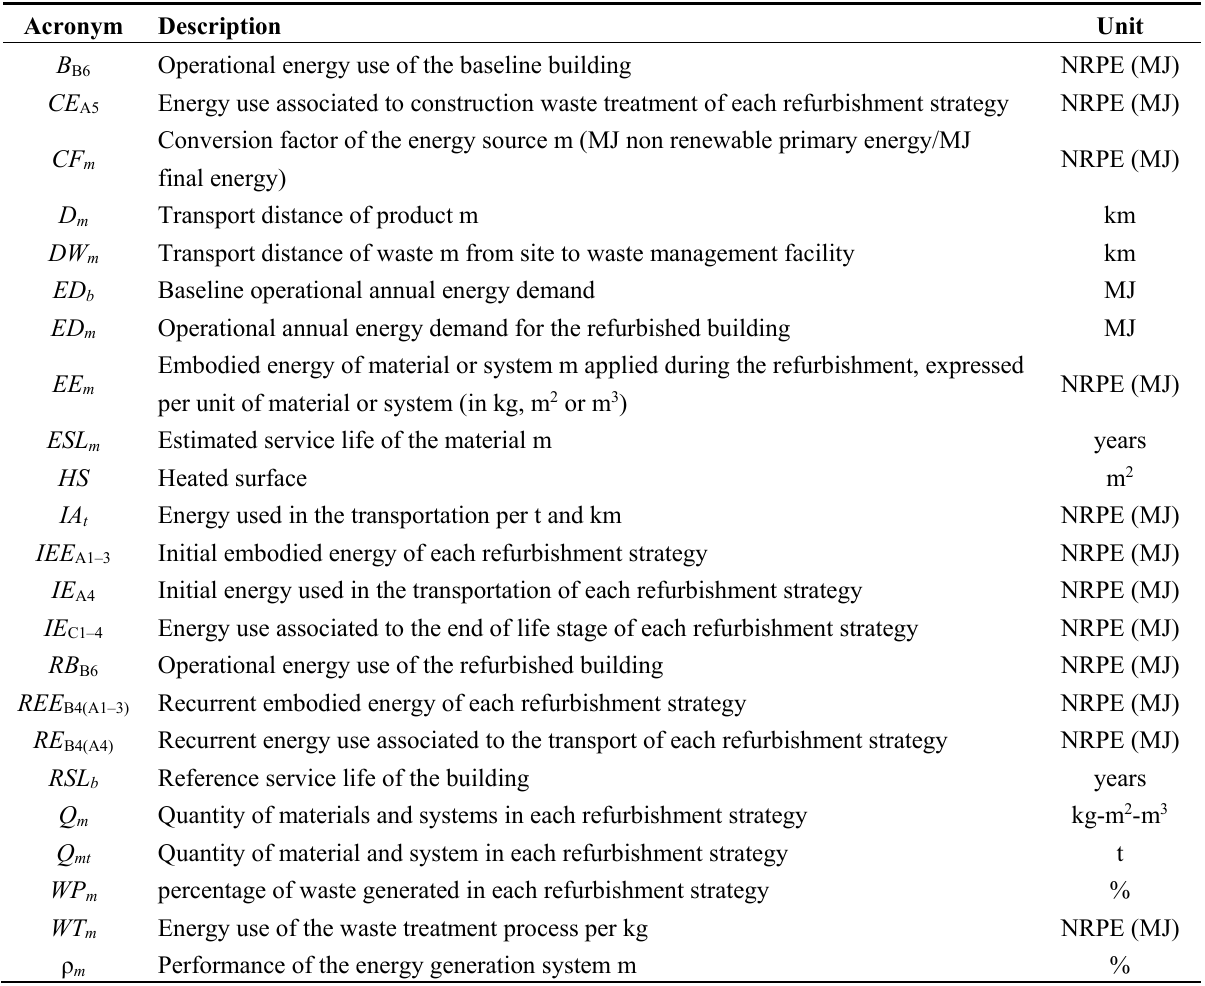
Table 3. Variables applied during the calculation of the Non Renewable Primary Energy (NRPE) of each building life cycle